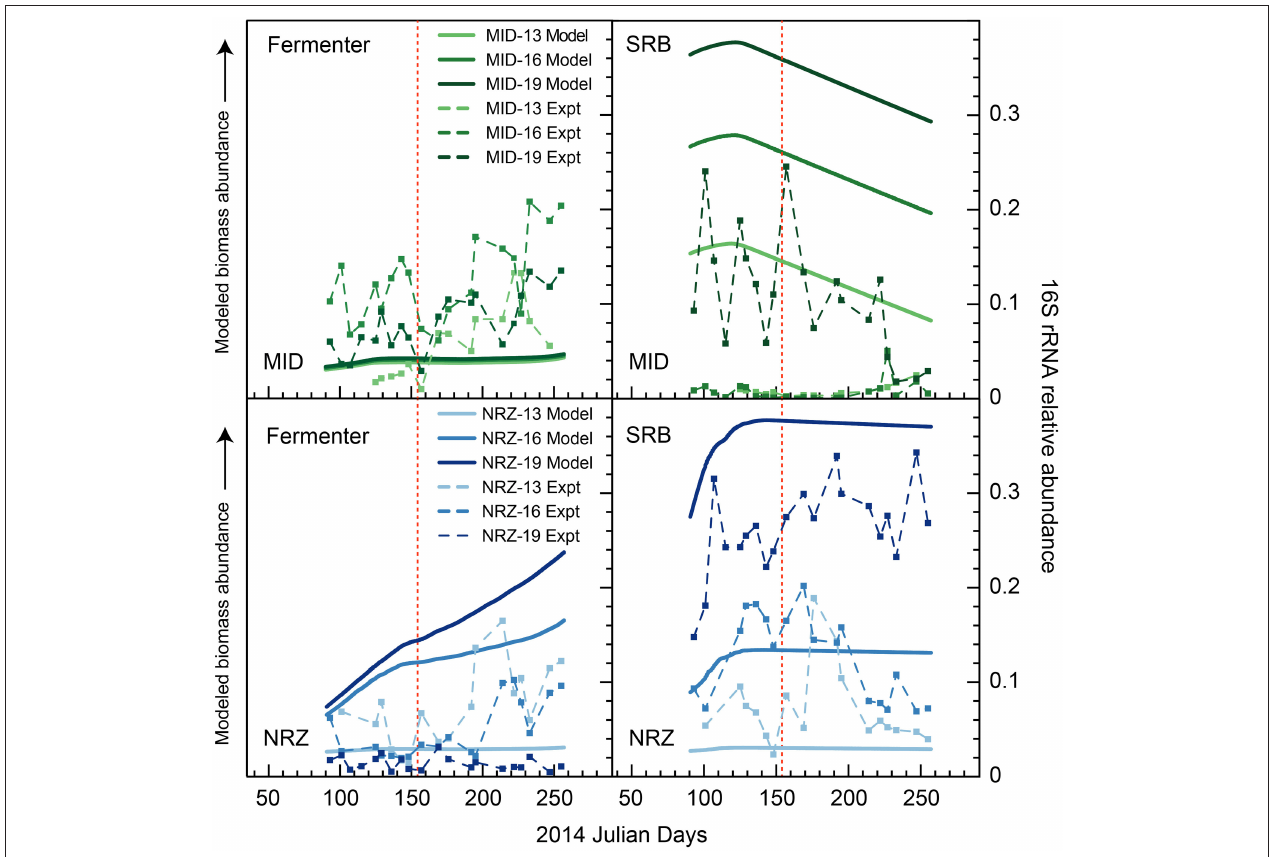
FIGURE 6 | Modeled biomass and 16S rRNA gene relative abundance (“experimental”) during the monitoring period in wells MID and NRZ for two key functional groups—inferred fermenters, and SRB. For temporal shifts in 16S rRNA gene relative abundances, fermenters are represented by members of candidate phyla OD1 (Parcubacteria), while SRB are represented by members of the Desulfobulbaceae and Desulfobacteraceae . Modeled biomass is presented to illustrate relative differences between depths within a sample, and changes over time. Scales for each modeled dataset are different and so should not be directly compared between functional groups or wells. The red line marks the date of peak water table height in the aquifer.